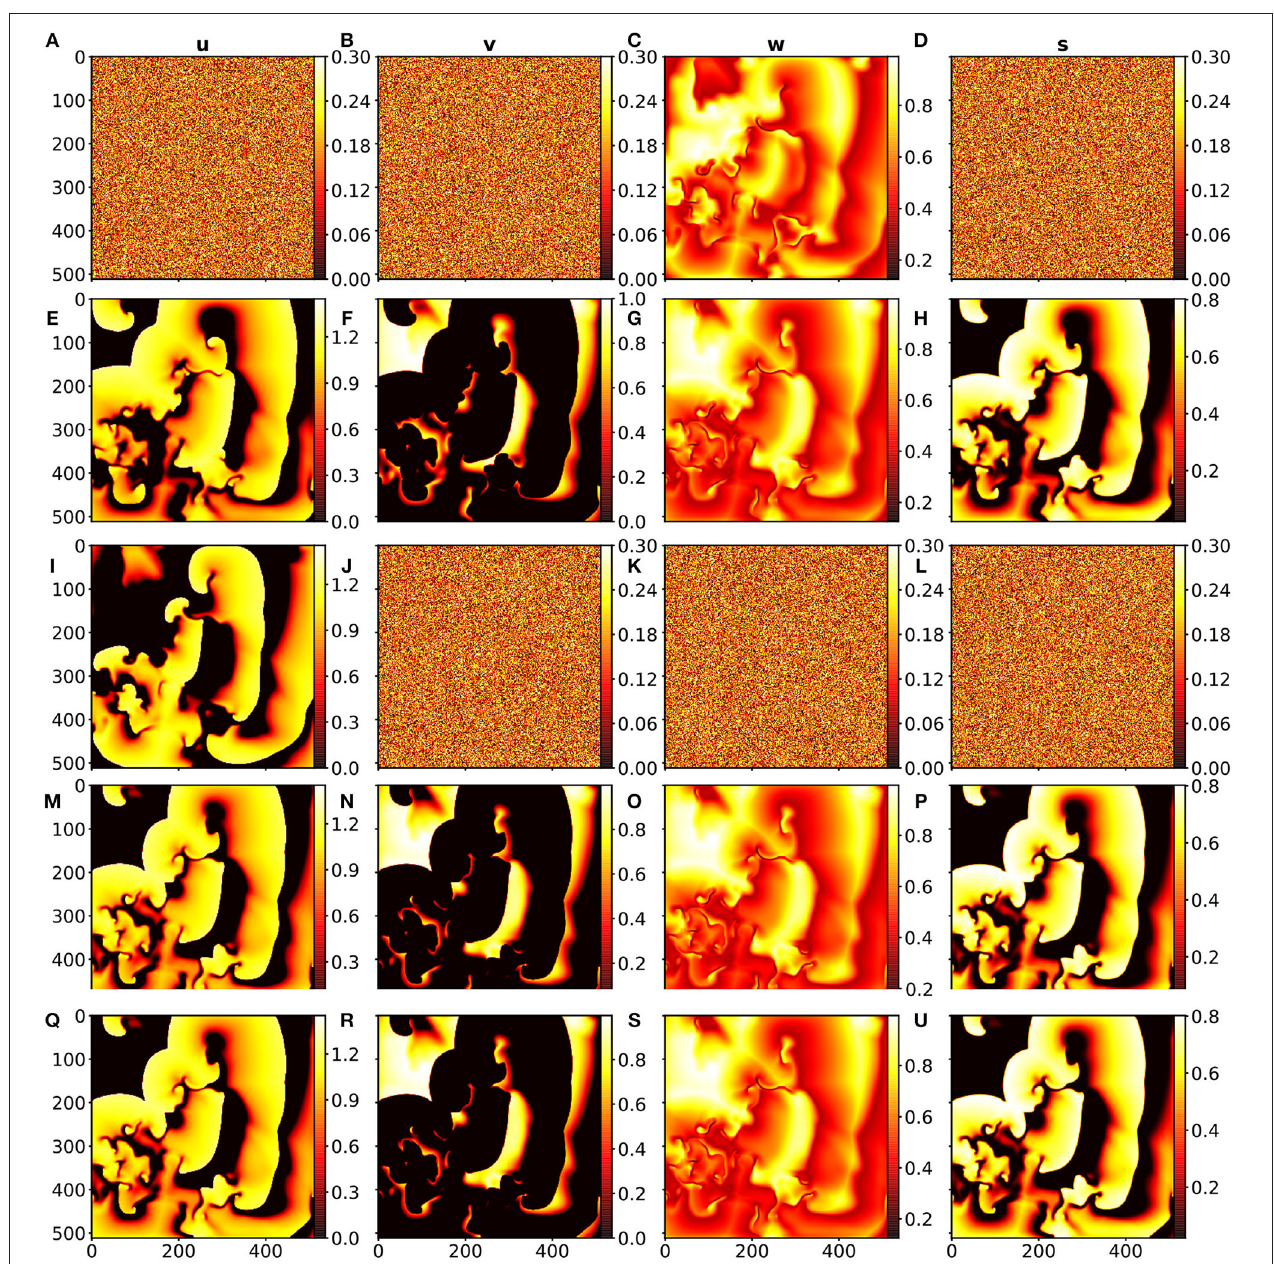
FIGURE 7 | (A–H) : Cross estimation of u , v , s at t = 100 based on the input w at t = 0 where (A,B,D) is the random noise input for the system variables u , v and s , (C) is the snapshot input of w at t = 0 (estimation). (E–H) show the output of the data-driven model for the system variables u , v , w , s at time t = 100. (I–P) : Cross estimation of v , w , s at t = 100 based on the input u at t = 0 where (I) shows the snapshot input of u at t = 0. (J,K,L) show the random noise input for the system variables v , w and s , (M–P) is the output of the data-driven model for the system variables u , v , w , s at time t = 100 (prediction). (Q–U) : Reference data from the BOCF model for time t = 100, where (Q–U) are the snapshots for the system variables u , v , w , and s .